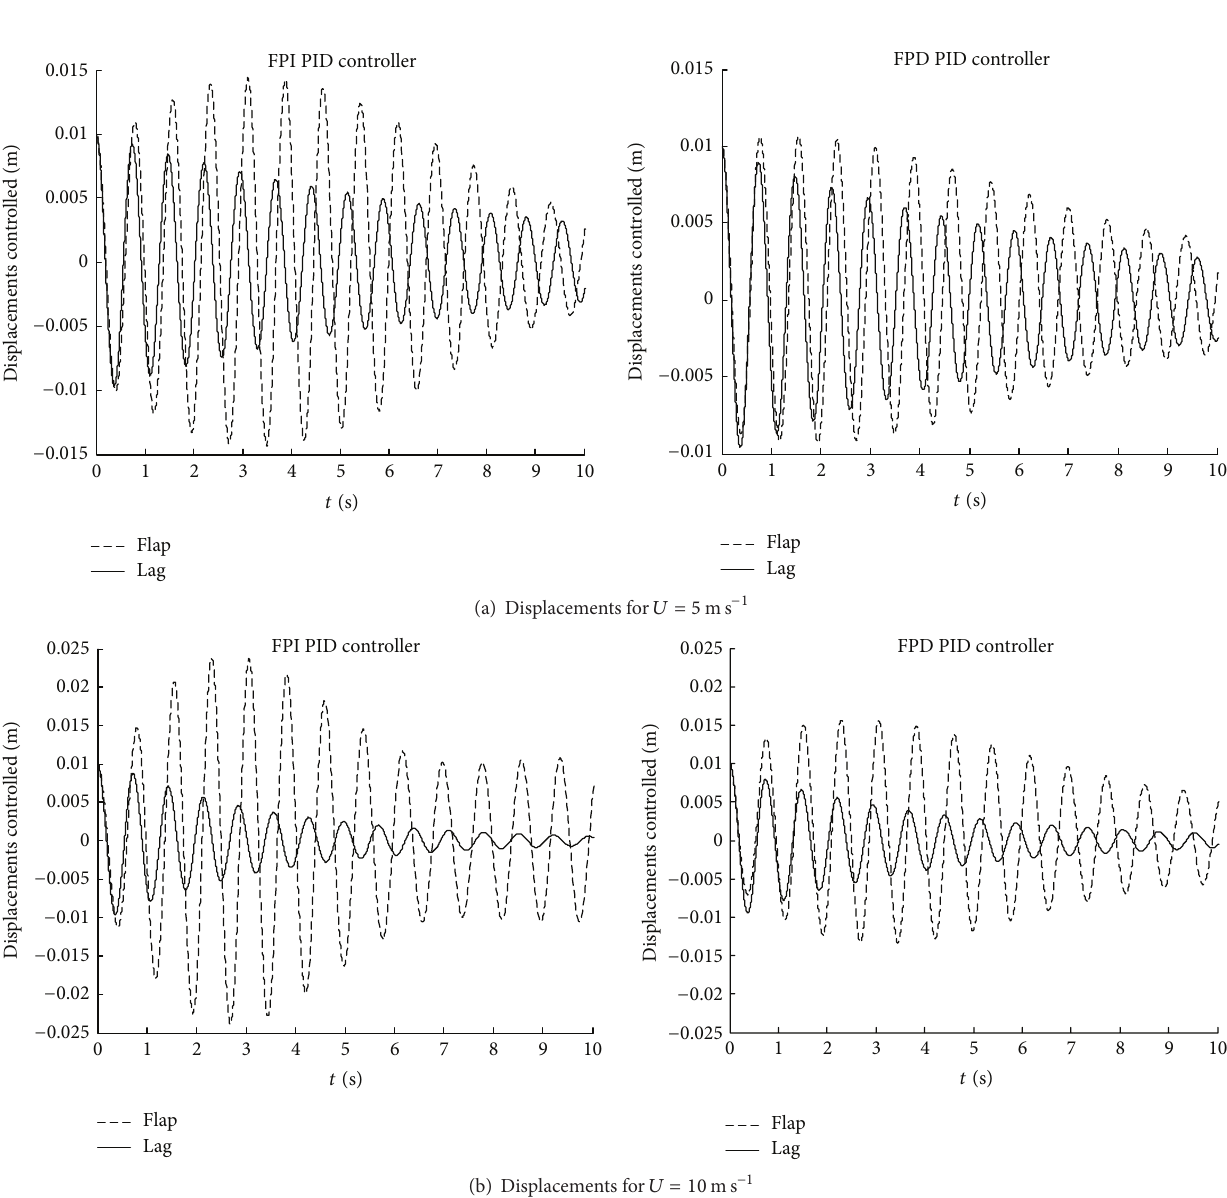
Figure 9: Flap and lag displacements of Case one for different fuzzy